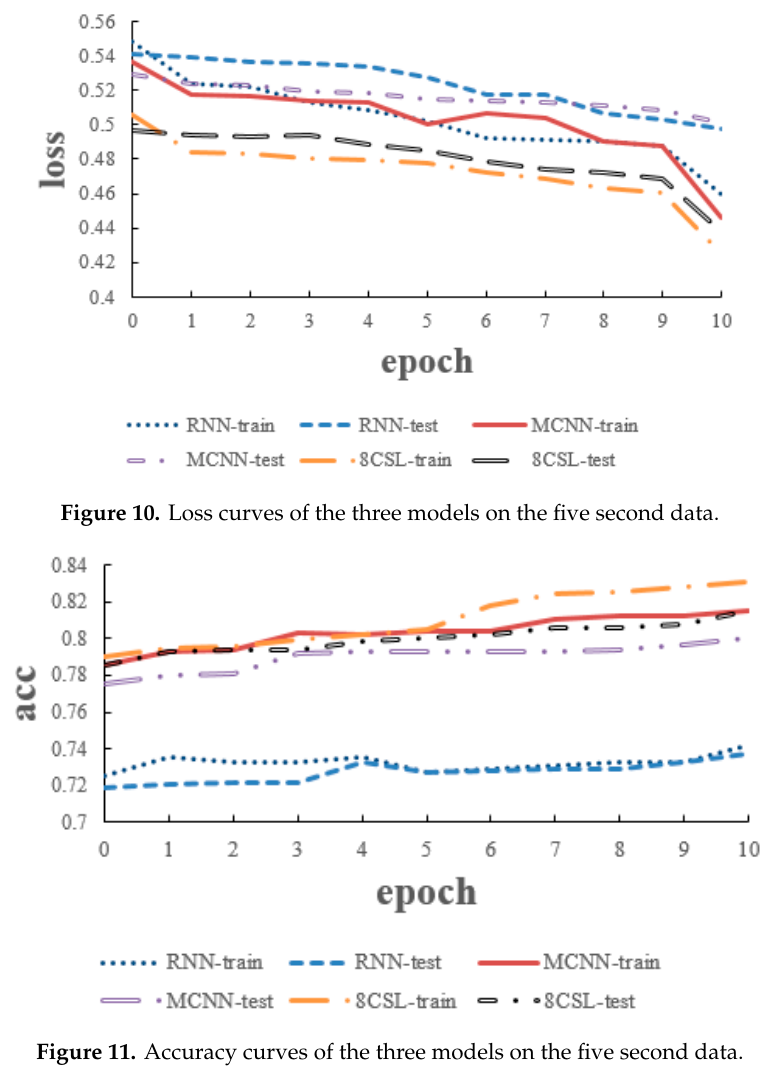
Figure 11. Accuracy curves of the three models on the five second data.